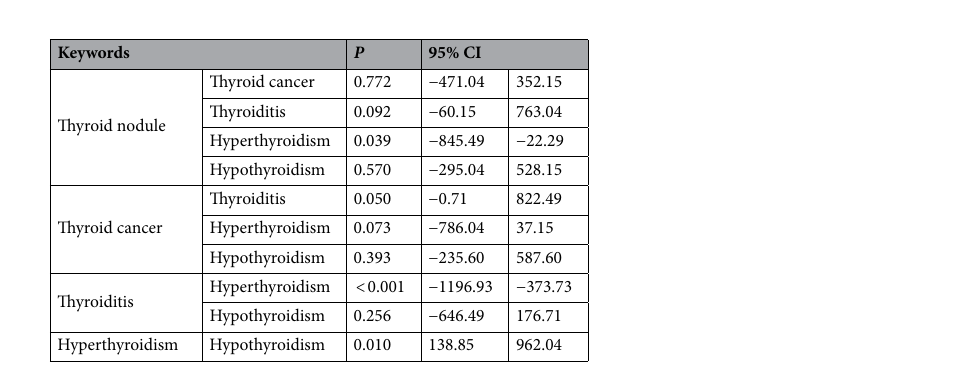
Table 4. Multiple comparisons between keywords (media